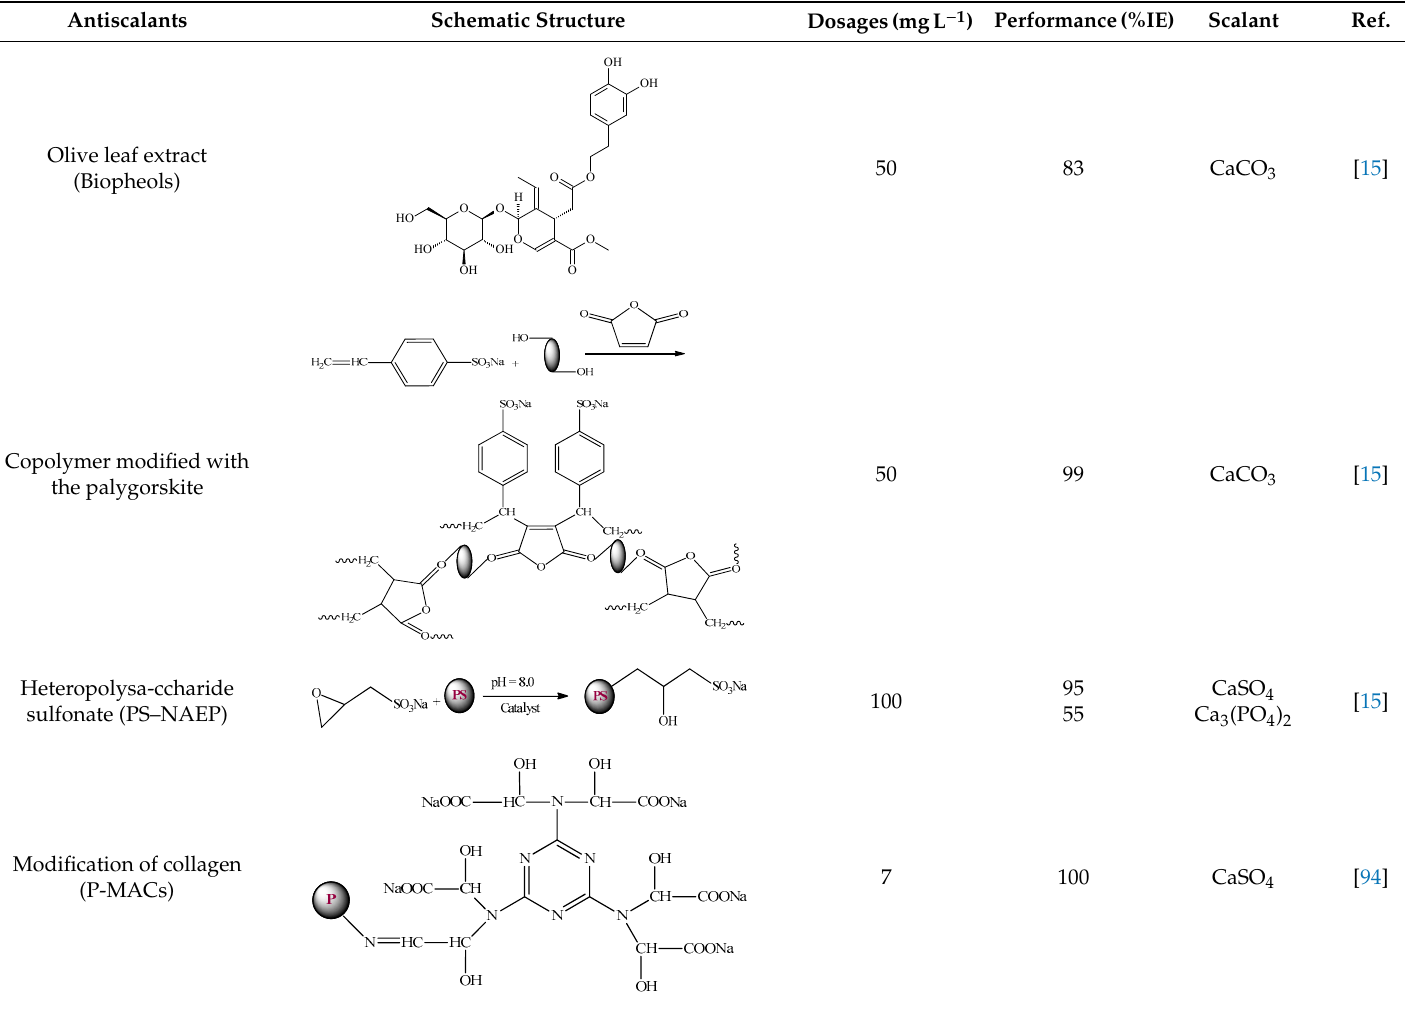
Table 2. Characteristics of antiscalant properties of some natural organic molecules.